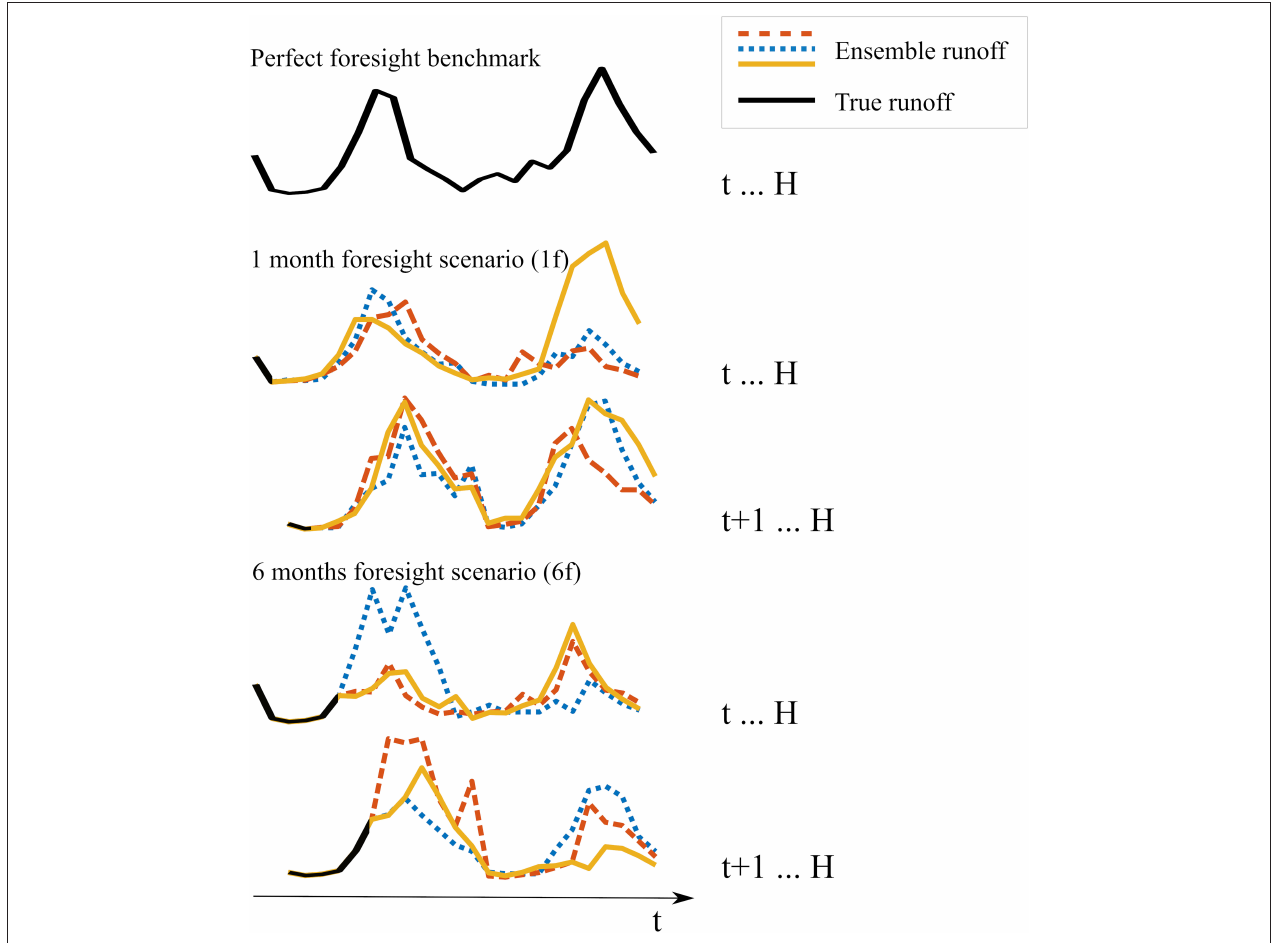
FIGURE 5 | Conceptual illustration of the continuous imperfect forecasting used in the LP-MPC framework, compared to the deterministic perfect foresight.